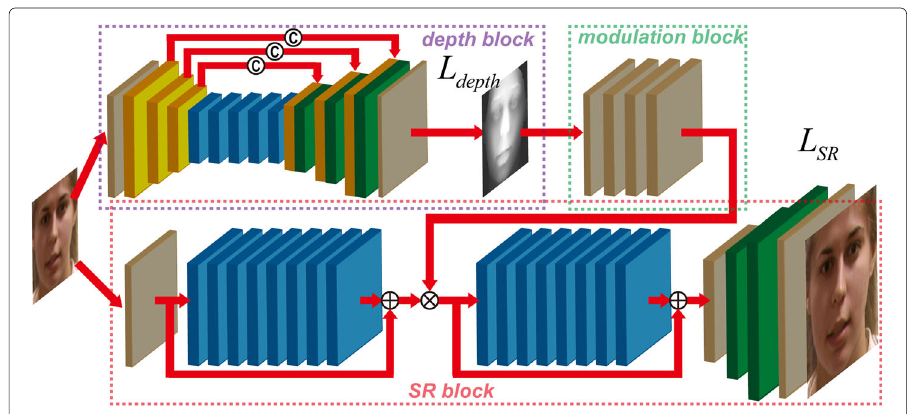
Fig. 2 Network architecture. The basic network structure with the depth block, the modulation block, and the SR block. The input and output channel sizes are commonly annotated in Fig. 3 for each convolutional layers specified in different colors. In the special cases for the input and output layers that take the 3-channel images as inputs or outputs, the input and output channel sizes should be modified to be compatible with the input and output images